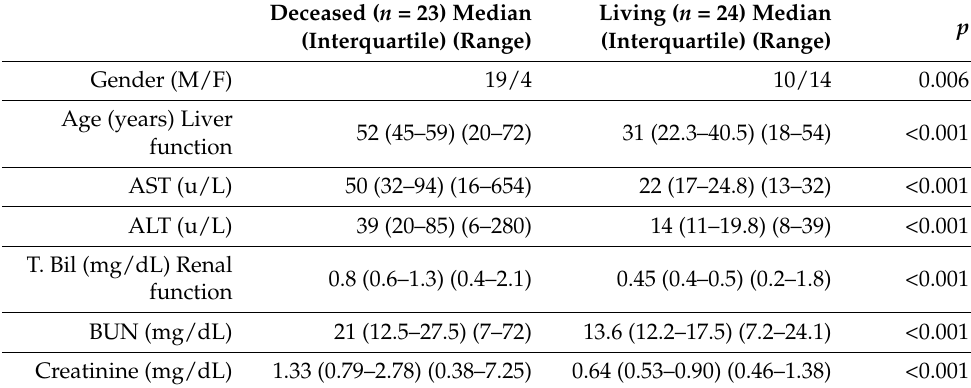
Table 1. The characteristics of deceased and living liver